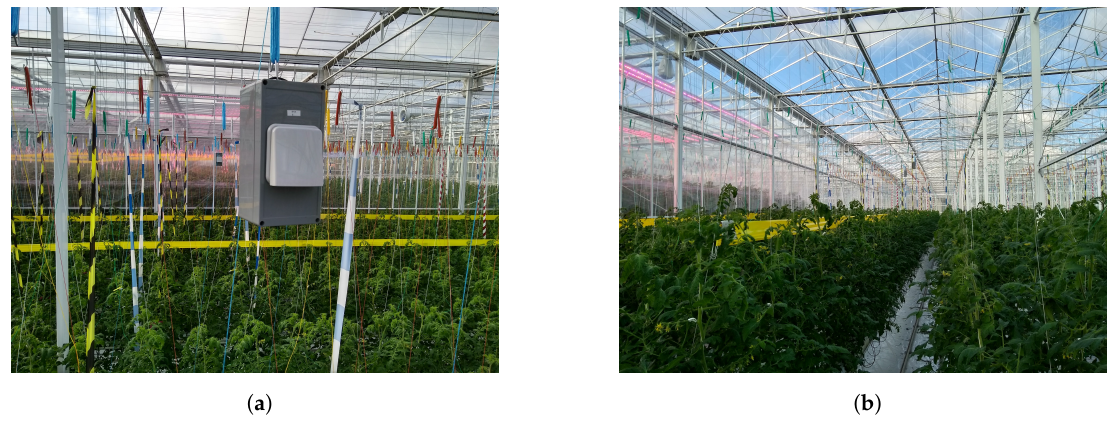
Figure 1. Layout of the greenhouse (PCH research center) where we conducted our measurements with our deployed sensor box. ( a ) Rectangular box as mounted in the greenhouse; ( b ) rows of tomato plants. Table 1. Challenges for PA in